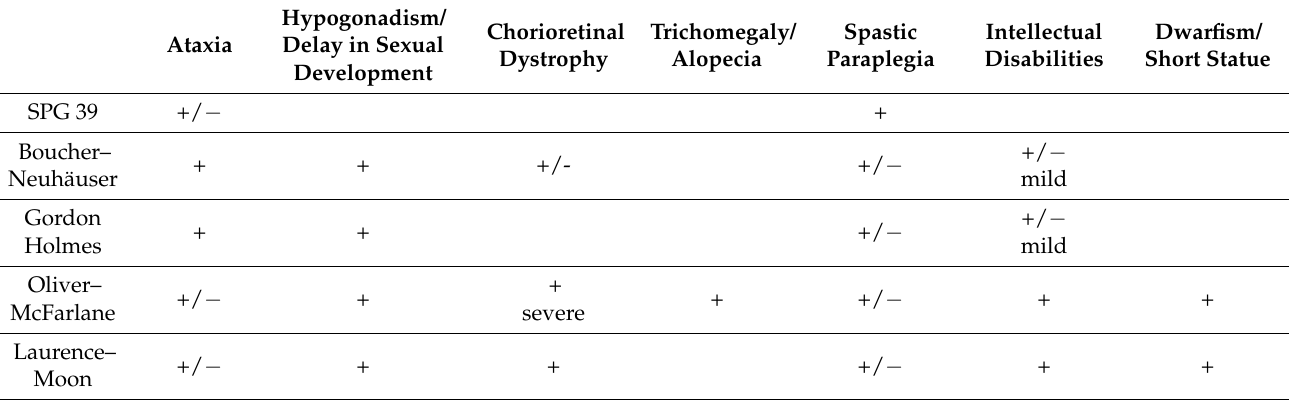
Table 1. PNPLA6-related disorders. Characteristic clinical features are indicated by +. Clinical features not detected in all patients are indicated by +/ − .